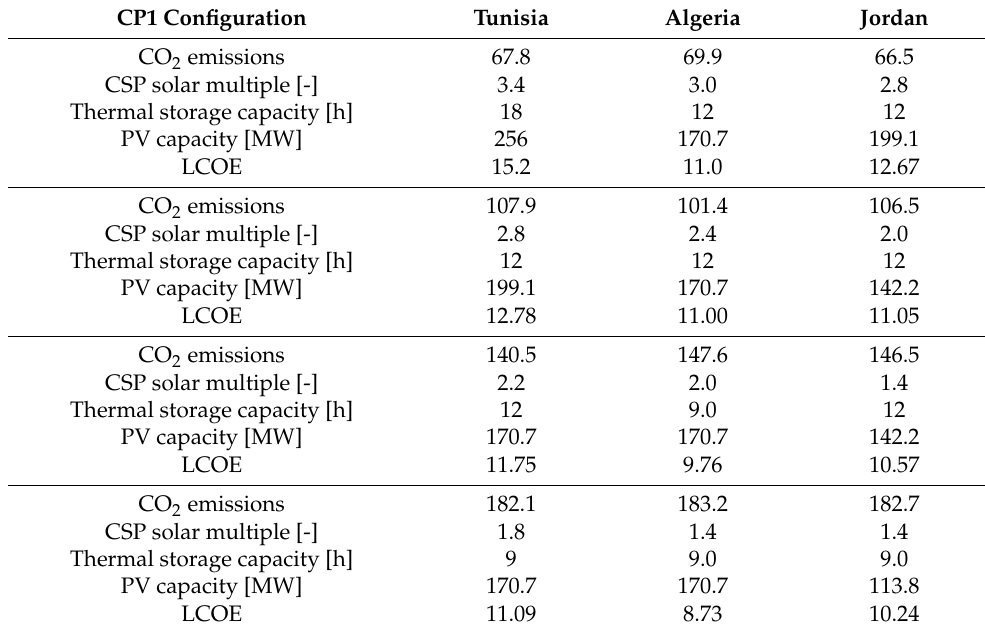
Table 6. Key results of LCOE optimization for CP1 case.